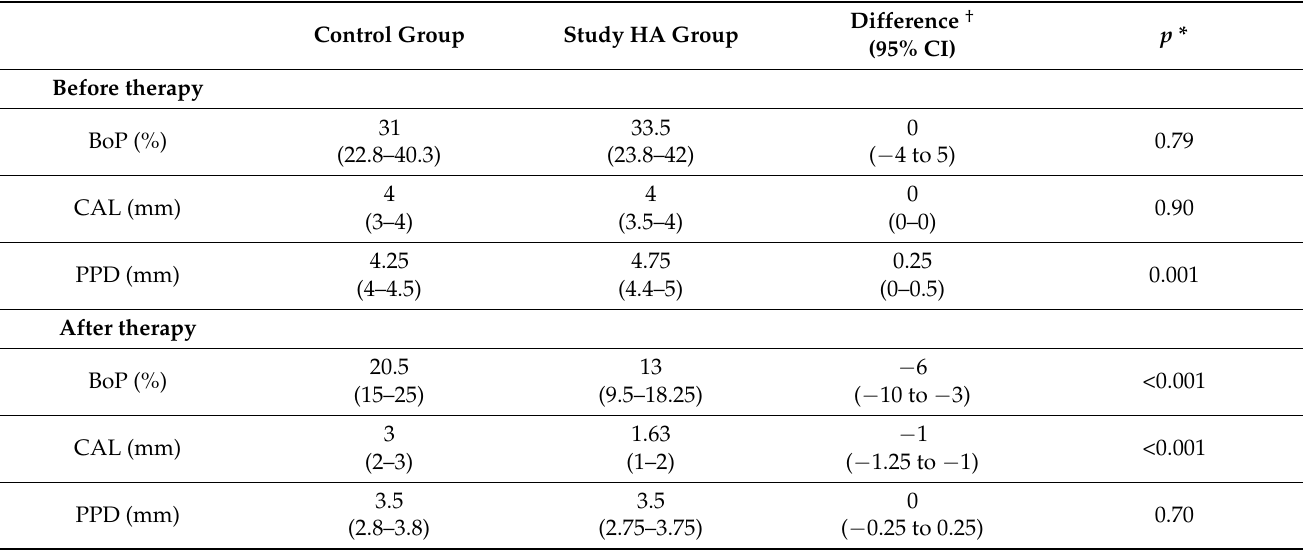
Table 1. Clinical parameters before and after therapy in the study and control groups.